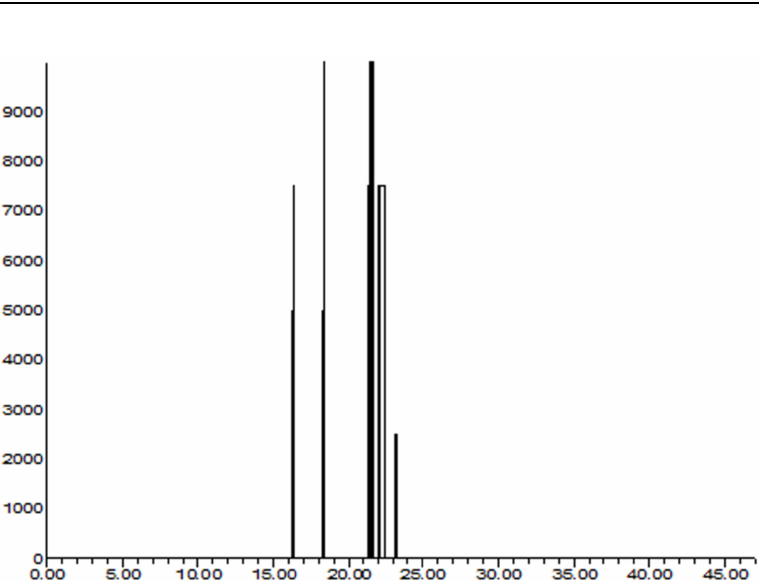
Figure 2. Representative aromagram of odor-active aroma compounds (OAACs) in basil (